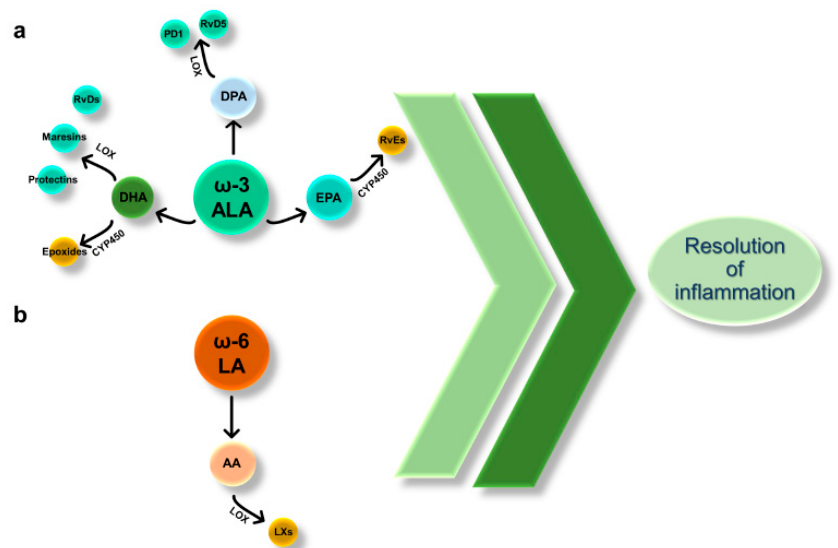
Figure 2. Ω -3 and ω -6-derived lipids enhance the resolution of inflammation. ( a ) Essential fatty acid α -linolenic acid (ALA) is converted to eicosapentaenoic acid (EPA), docosahexaenoic acid (DHA), and Docosapentaenoic acid (DPA). EPA and DHA may be the substrates of CYP450, resulting in the